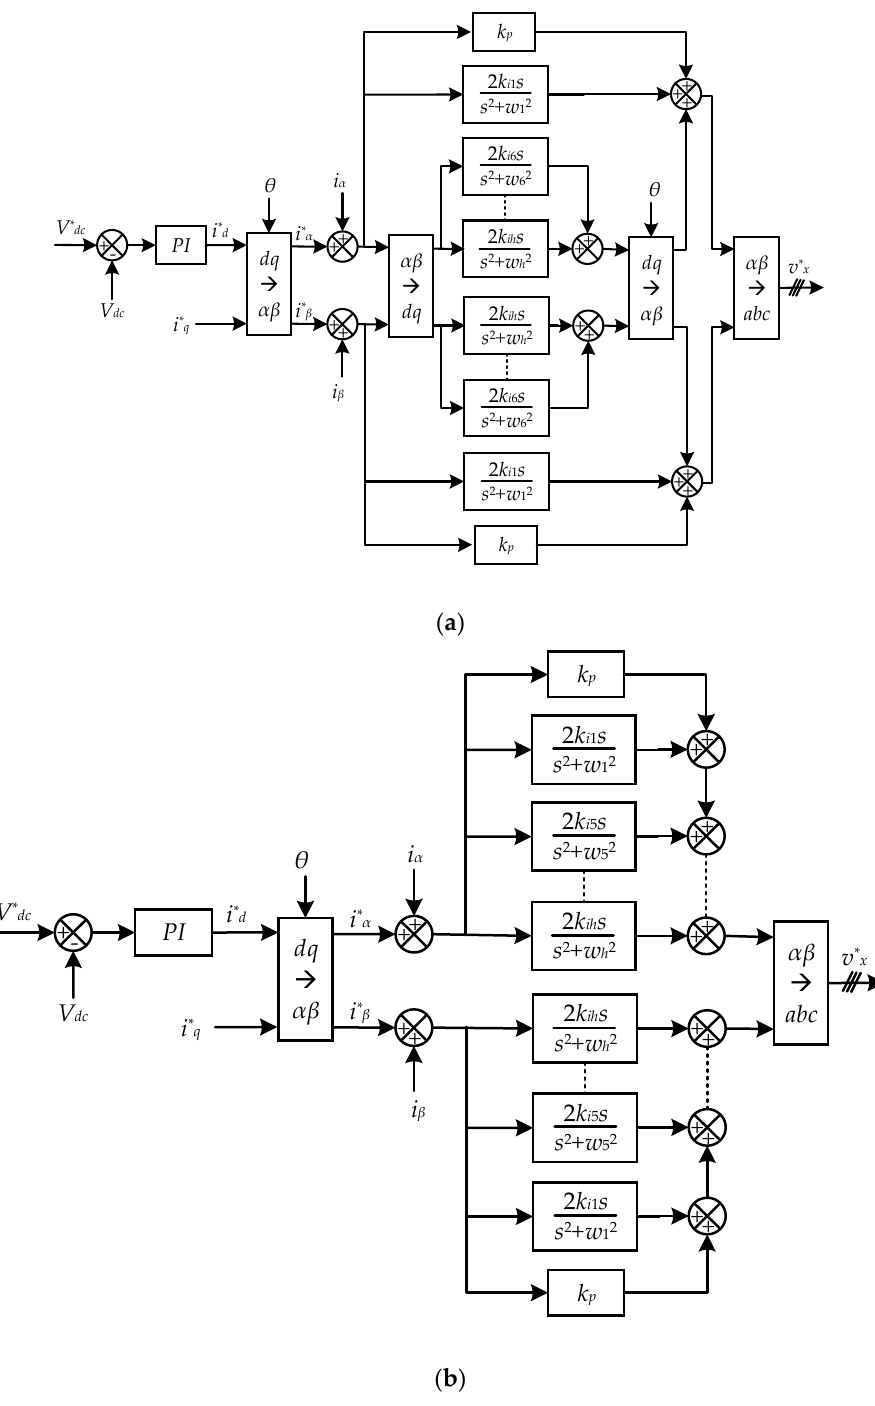
Figure 10. Output voltage and current control under distorted grid condition: ( a ) in αβ -dq frame; ( b ) in αβ frame.